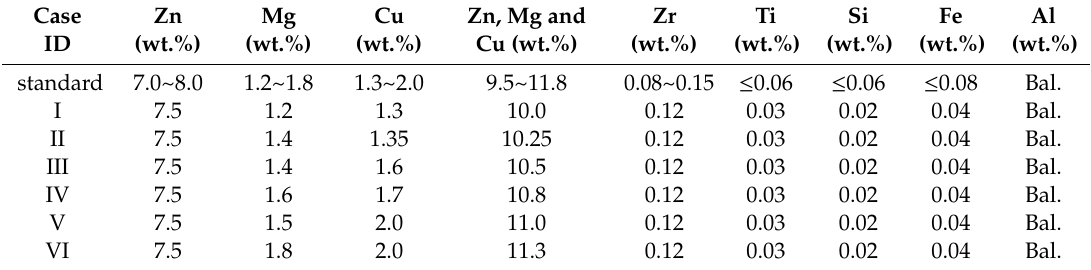
Table 1. Chemical compositions of 7085 aluminum alloys for comparison